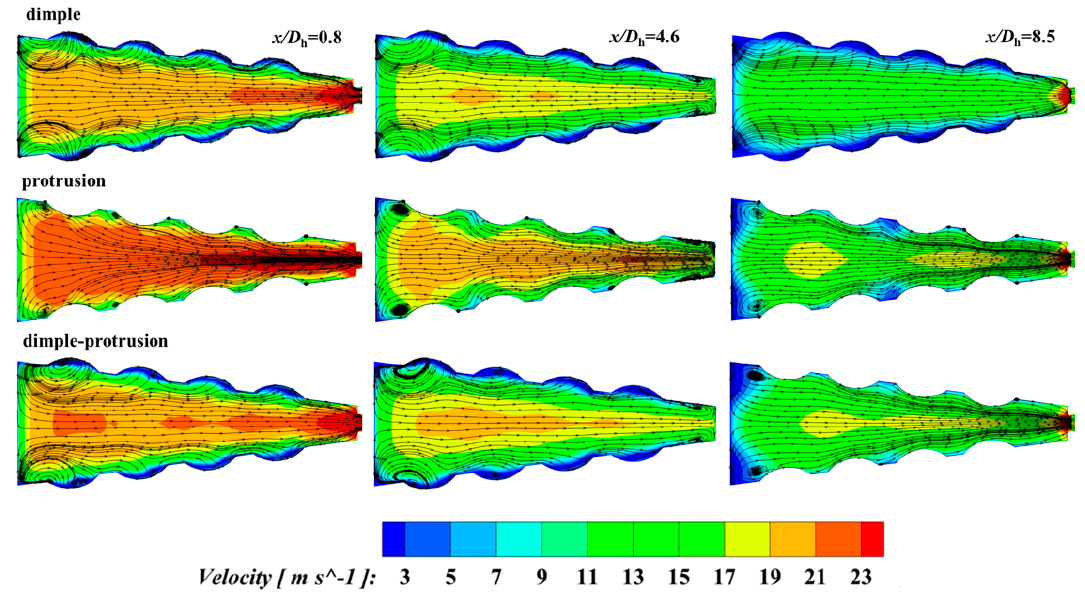
Figure 9. Streamlines and velocity distributions on several cross sections for different dimple/protrusion arrangements, Re = 30,000.